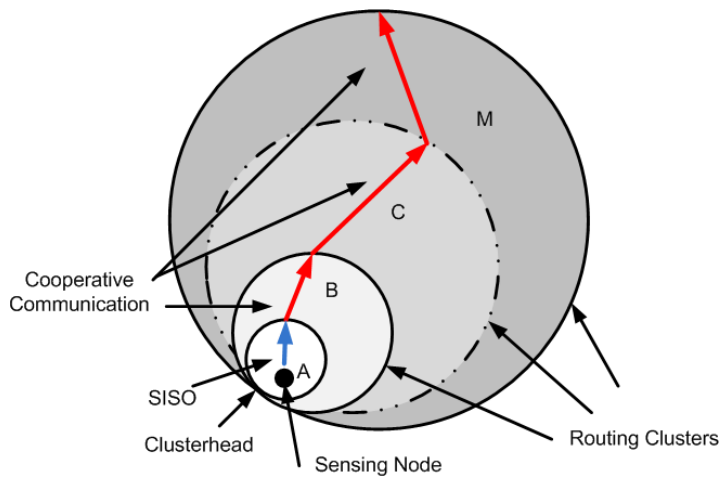
Figure 2. Hierarchical cooperative